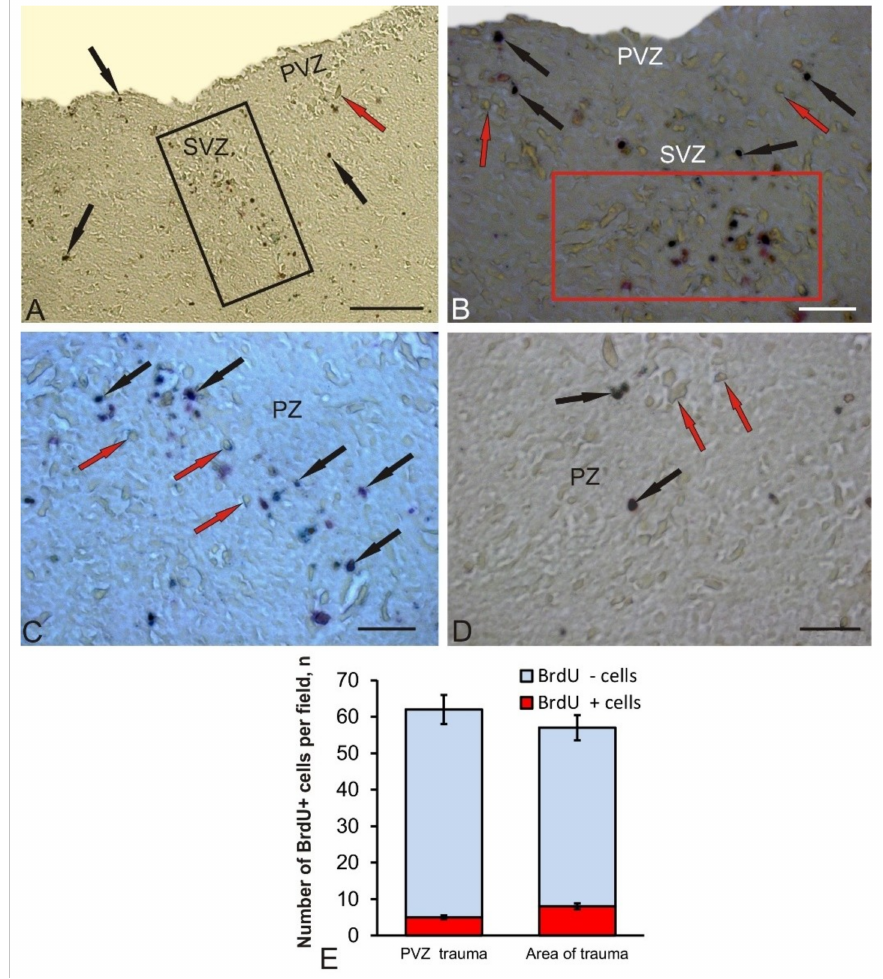
Figure 2. Representative image of BrdU-labeling in the area of injury and adjacent areas of the mesencephalictegmentumofjuvenilechumsalmon, Oncorhynchusketa , onday3post-injury. ( A )General view of the injury area; a heterogeneous accumulation of BrdU + cells in the injury zone is outlined by a black rectangle; other designations as in Figure 1. ( B ) Dorsal part of the injury area at high magnification; a heterogeneous accumulation of BrdU + and BrdU– cells is outlined by a red rectangle. ( C ) The ventral part of the injury area containing heterogeneous BrdU + cells; ( D ) Near-injury parenchymal zone. Immunoperoxidase BrdU-labeling. ( E ) The ratio of BrdU +/ BrdU– cells in the PVZ and the injury area after damage to tegmentum (M ± SD). Scale bar: (A) = 200 µ m; (B–D) = 50 µ